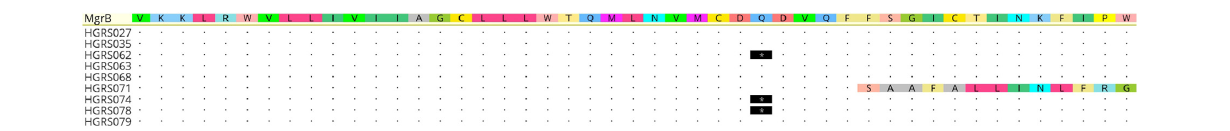
FIGURE 2 | Alignment of the amino acid sequences of mgrB from ColR-CRKP strains that were not disrupted by insertion sequences. Dots indicate identical residues; asterisk indicates stop codon; letter indicates amino acid substitution. The first sequence in the alignment belongs to the wild-type strain Klebsiella pneumoniae MGH 78578